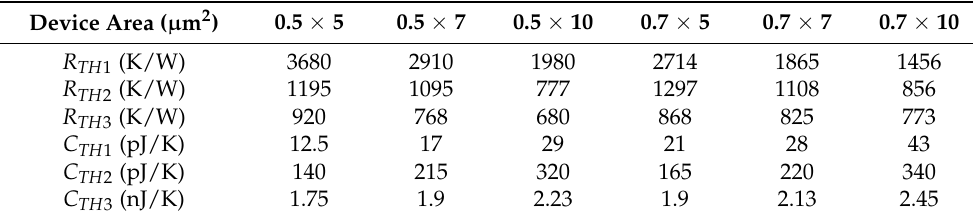
Table 1. Thermal resistance and capacitance contributions from the different epitaxial layers of the DHBT.